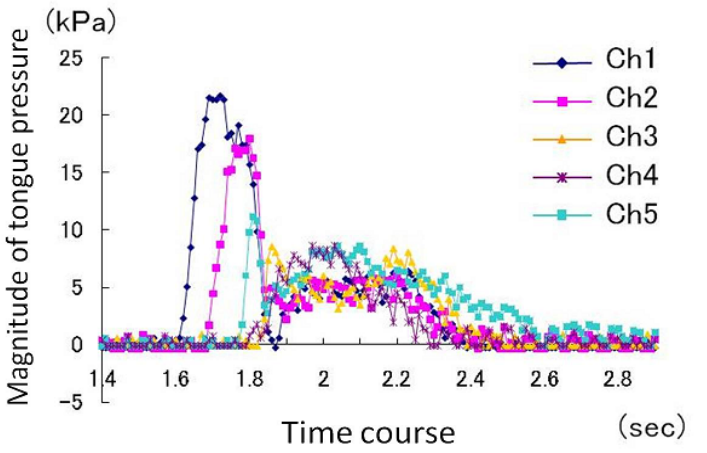
Figure 14. Representative recording of tongue pressure using a sensor sheet system during swallowing, in a healthy subject